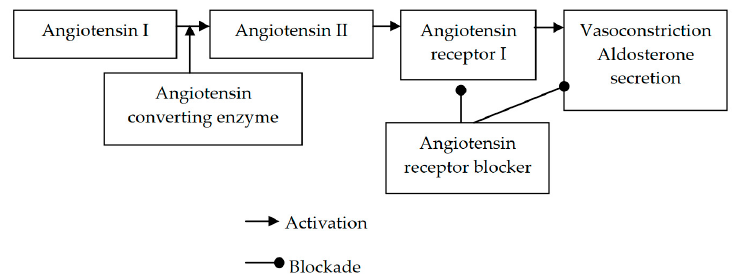
Figure 1. Mechanism of action of angiotensin receptor blockers.